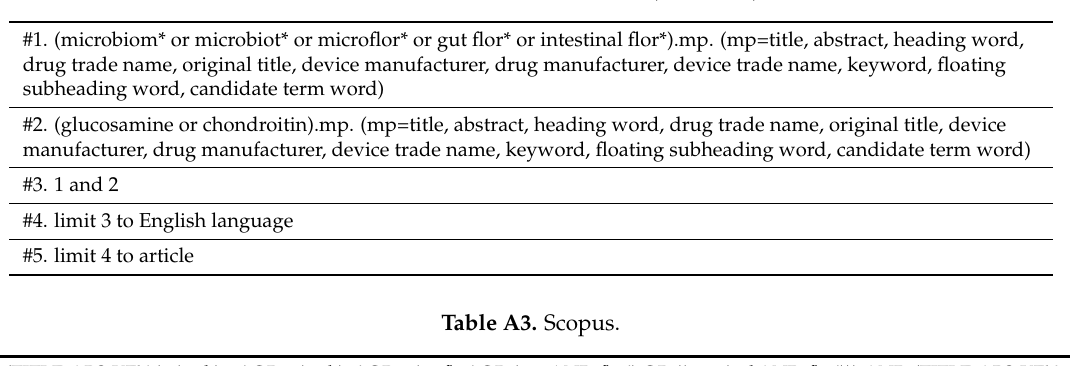
Table A2. MEDLINE and EMBASE (via OVID).